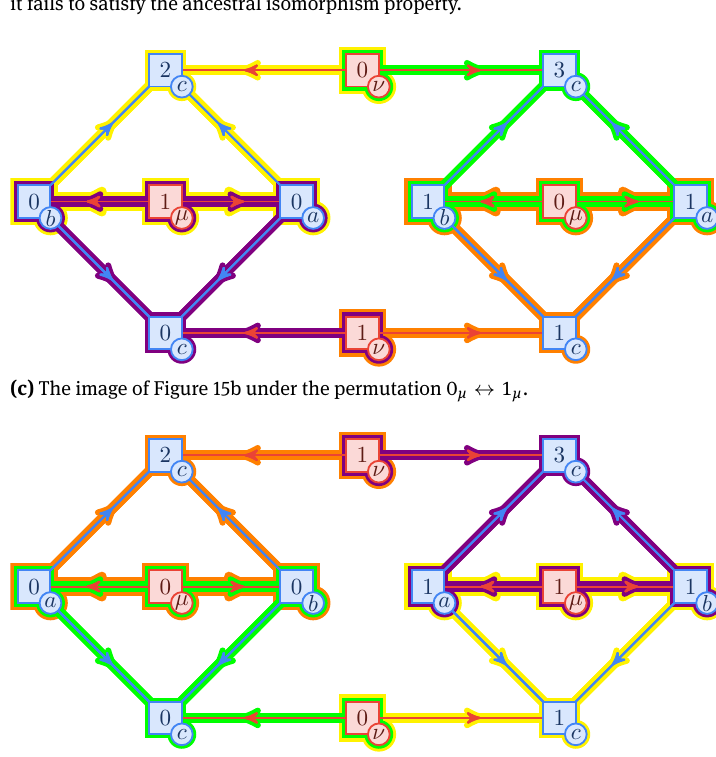
(d) The image of Figure 15b under the permutation 0 ν ↔ 1 ν . Figure 15: Every permutation π ℓ : Ω ℓ → Ω ℓ of valuations on the latent variables maps a possible worlds diagram to an- other possible worlds diagram with the same observed events. The worlds are colored: wor (0 µ 0 ν ) green, wor (0 µ 1 ν ) orange, wor (1 µ 0 ν ) yellow, and wor (1 µ 1 ν )